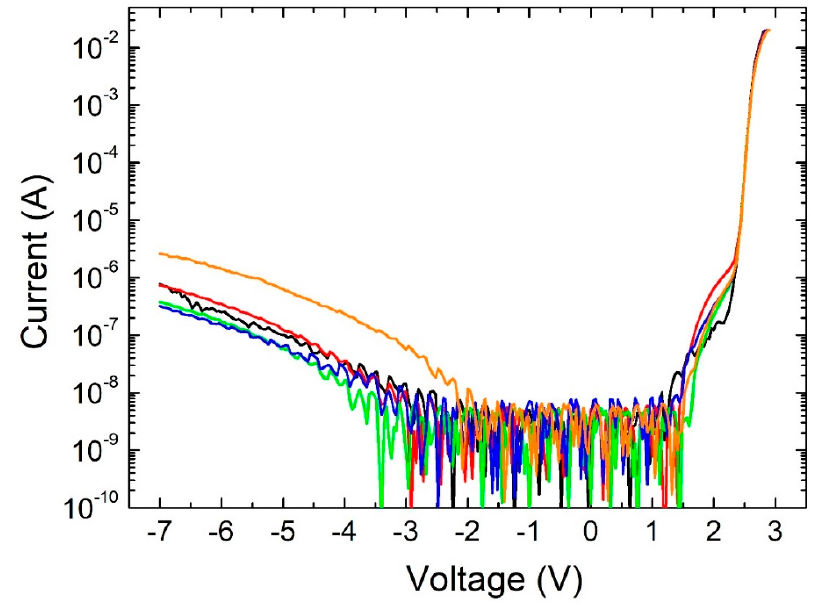
Figure 4. Current-voltage curves of the damaged LED Figure 4 . Current-voltage curves of the damaged LED chips.